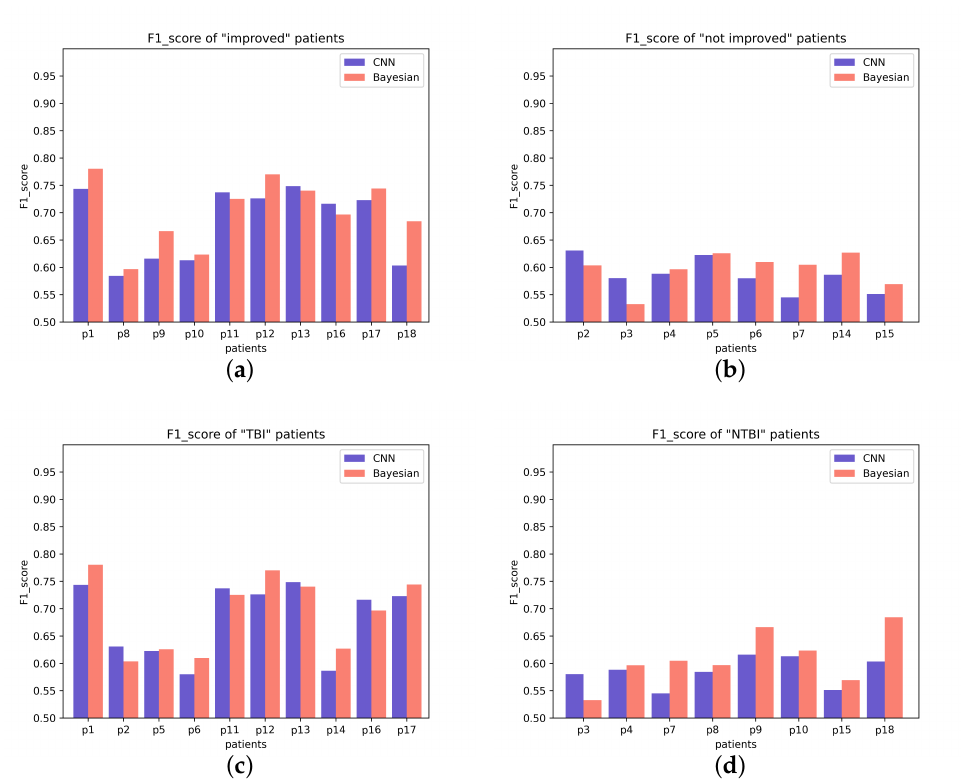
Figure 3. Upper panel: ( a , b ) represent the F1_score of “improved” patients and “not improved” patients, respectively; ( c , d ) represent the F1_score of TBI patients and NTBI patients, respectively.